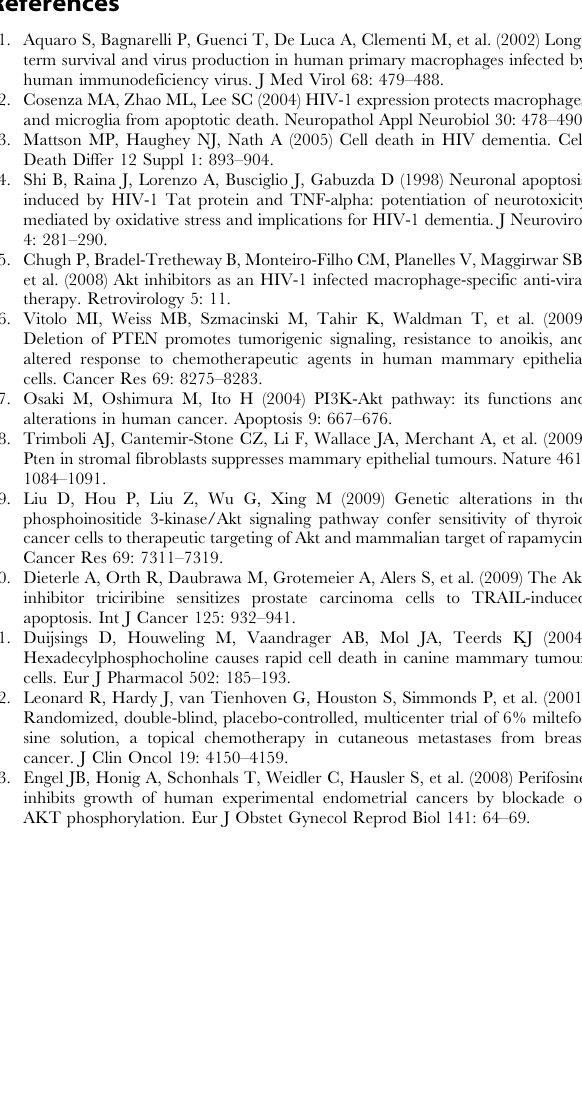
Figure S1 Akt and GSKb phosphorylation by DHIV-GFP in CHME5cells. 1 6 105 CHME5 cells were transduced by DHIV- GFP as described in Figure 2, and the cell lysates were analyzed by western blots for total (t) and phospho (p) specific Akt and GSK3 b . The fold differences in the signals are marked. Figure S2 Akt and GSK b phosphorylation by Tat expression in CHME5 cells. Lysates from 1 6 105 CHME5 sublines with